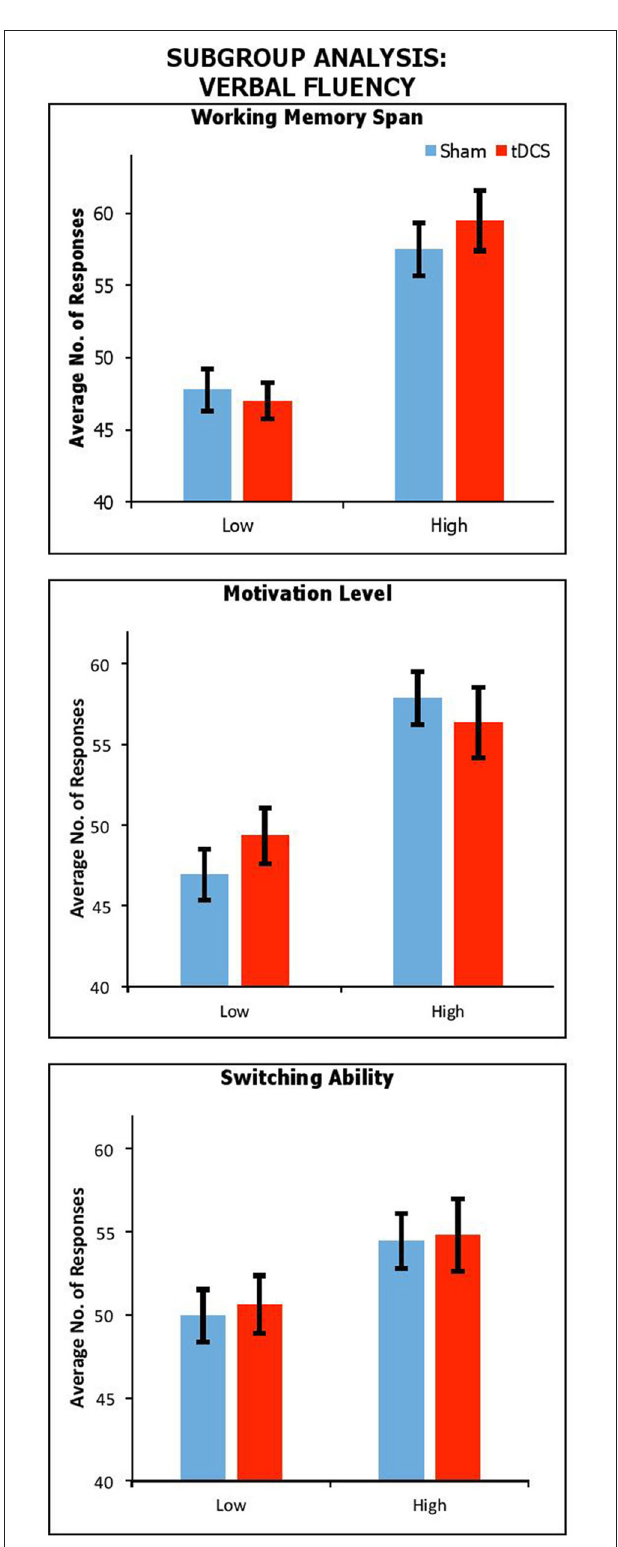
FIGURE 2 | Performance across stimulation conditions, with participants subdivided by Working Memory Span; Motivation Level; and Switching Ability. Error Bars indicate Standard